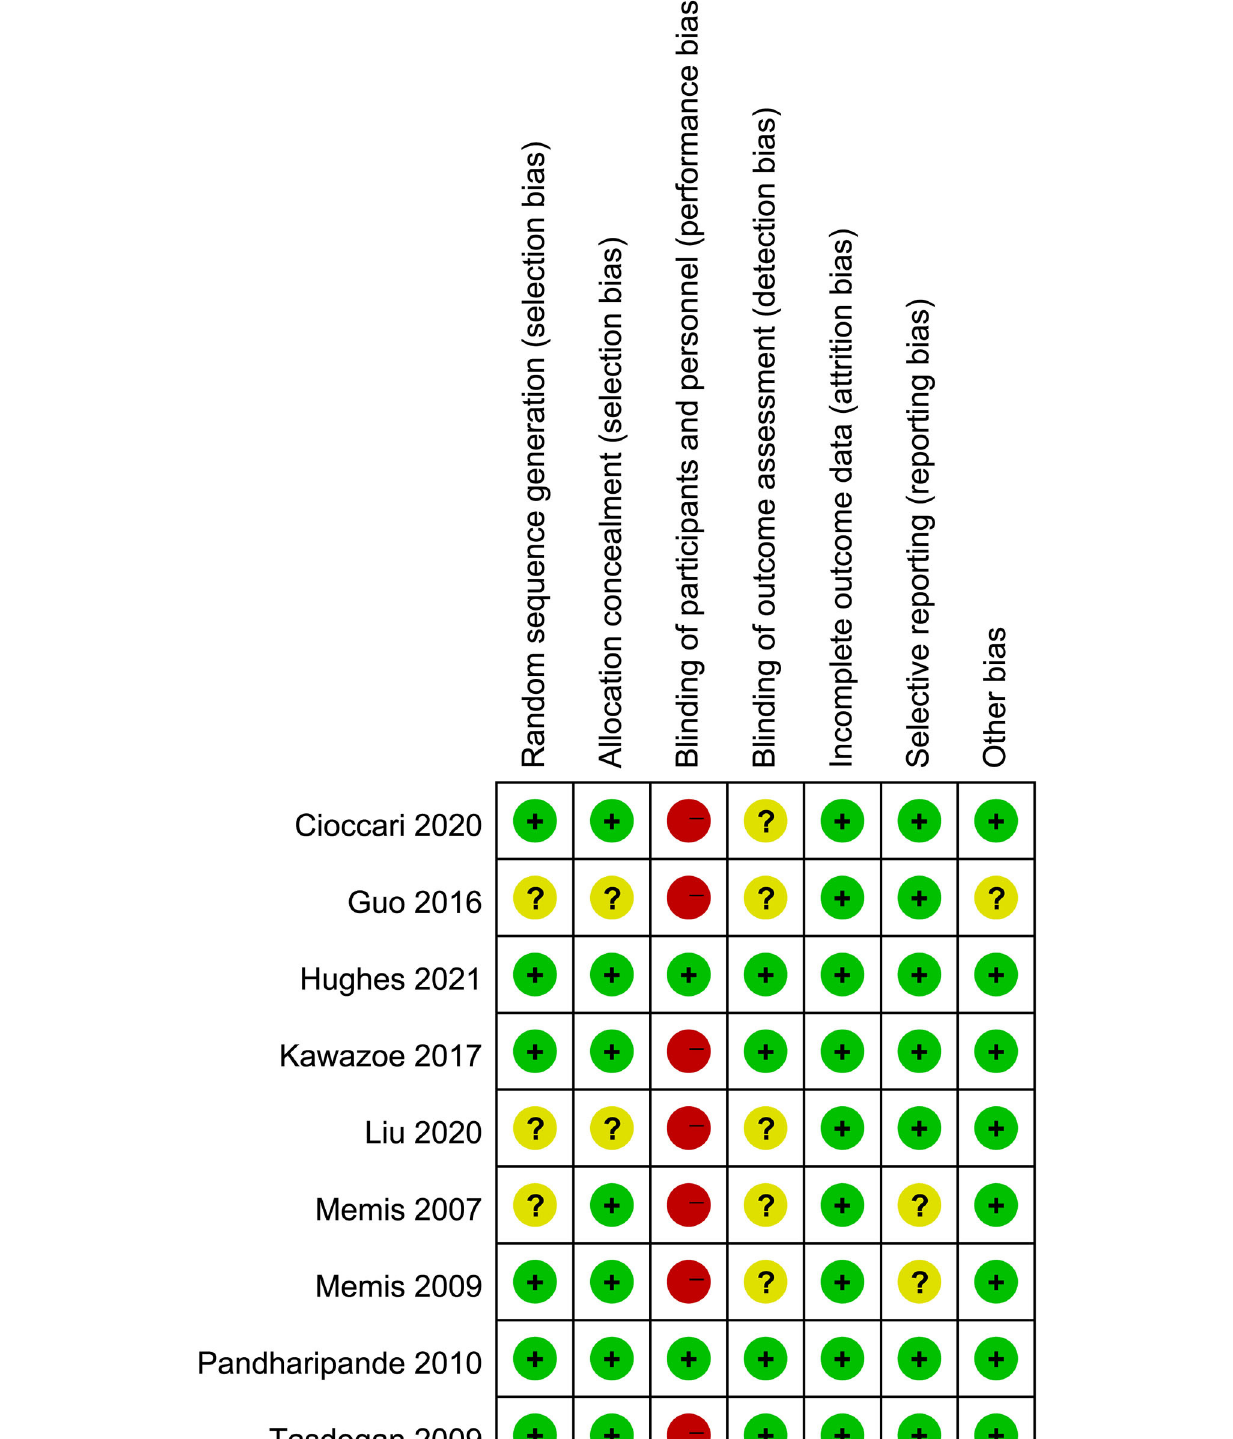
Frontiers in Medicine |